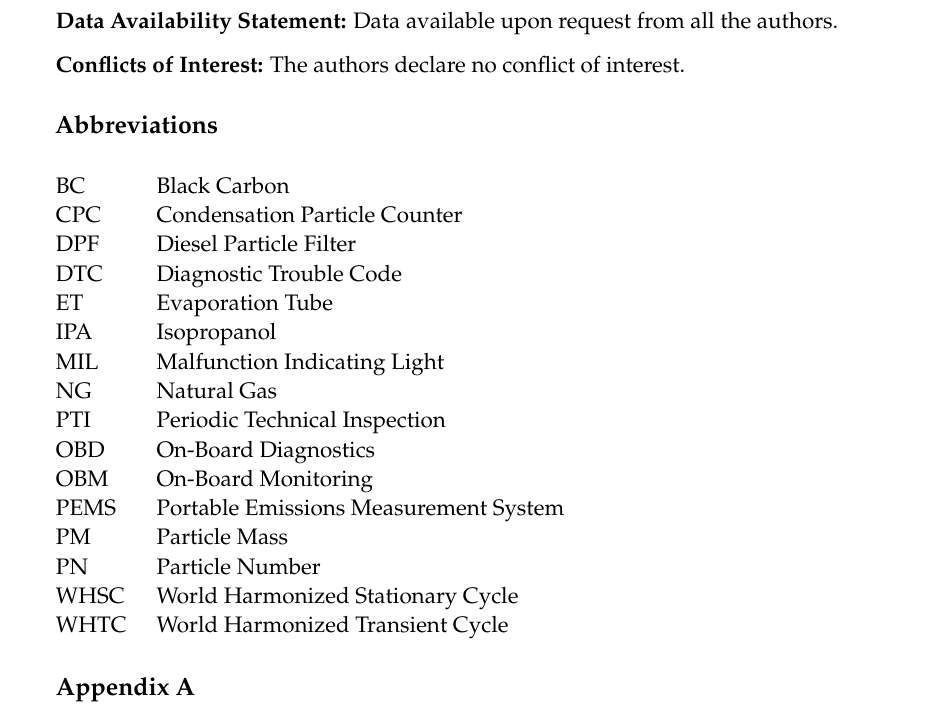
Table A1. Basic information on PEMS tested vehicles. Vehicle